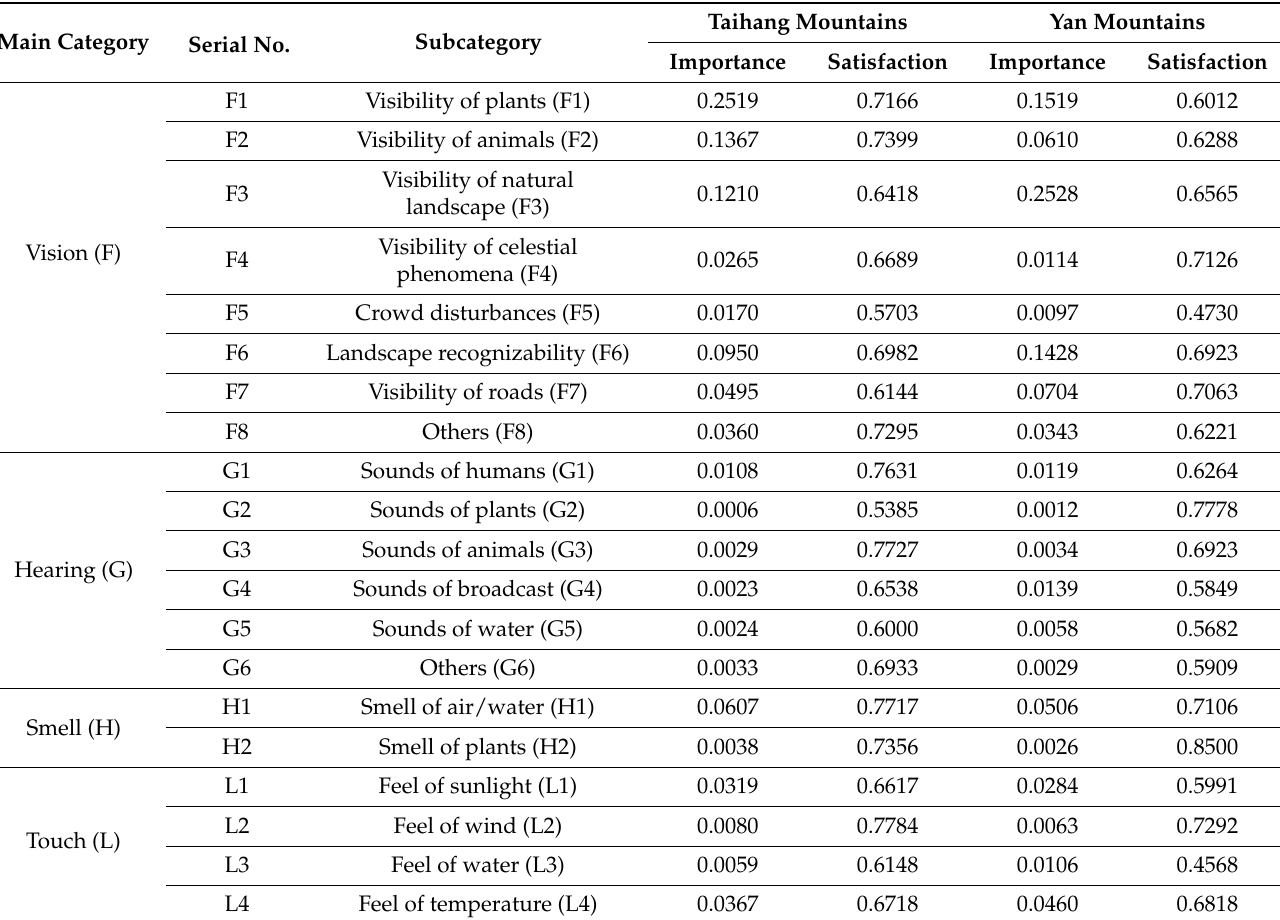
Figure 22. Integrated IPA of the experience of the five senses. Table 12. Importance and satisfaction scores of the experience of the five senses in different moun- tain